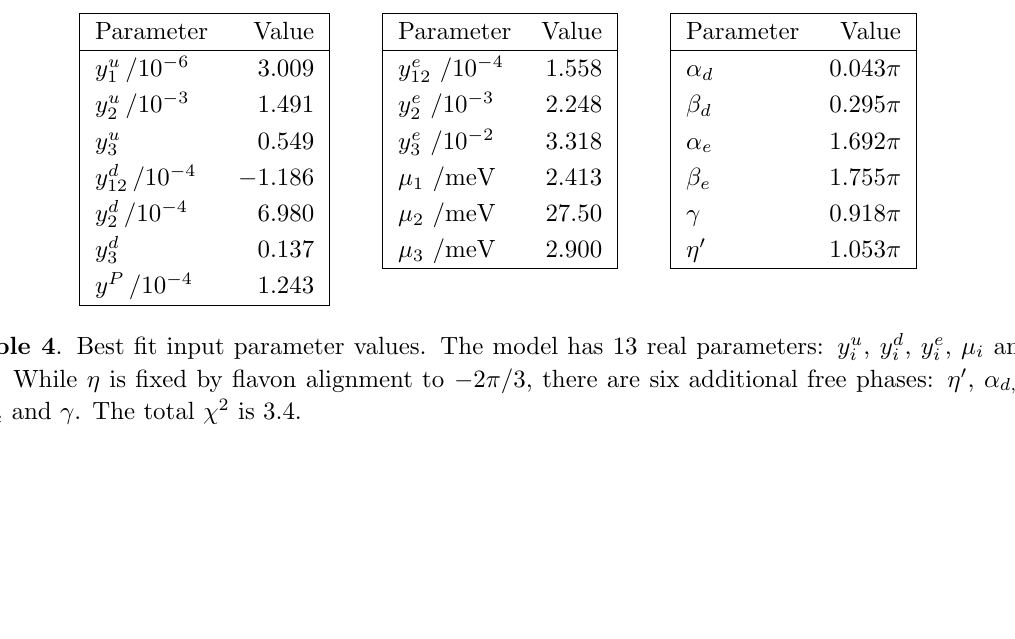
Figure 4 . Pulls for the best (cid:12)t of model to data, as shown in tables 2{3, for quark (blue) and lepton (yellow) parameters.